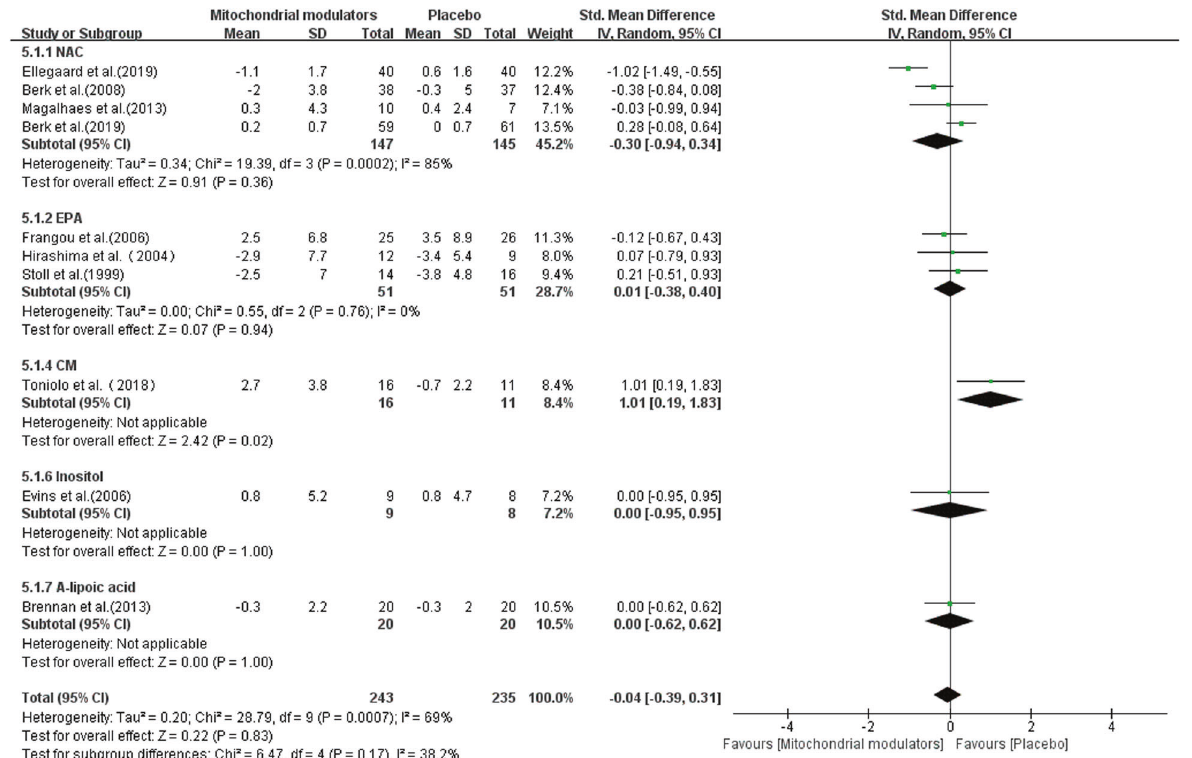
Fig. 4 Forest plots for YMRS reductions with mitochondrial modulators. CM creatine monohydrate, EPA eicosapentaenoic acid, NAC N- acetylcysteine, SD standard deviation, SMD standard mean